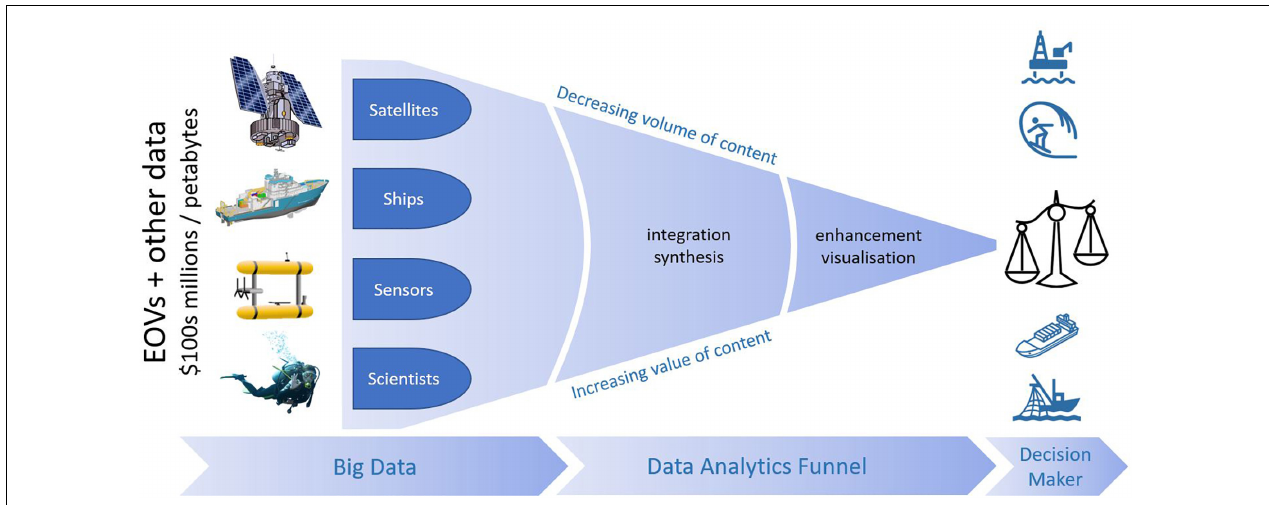
FIGURE 5 | Schematic of “data funnel” able to synthesize EOVs and other large data holdings in a form readily usable by decision makers and scientists. While the endpoint is “data products at finger tips,” this kind of system needs to make the underlying data readily findable and accessible from the data product. Seamap Australia is an example of this kind of technology (Butler et al., 2017; http://seamapaustralia.org).